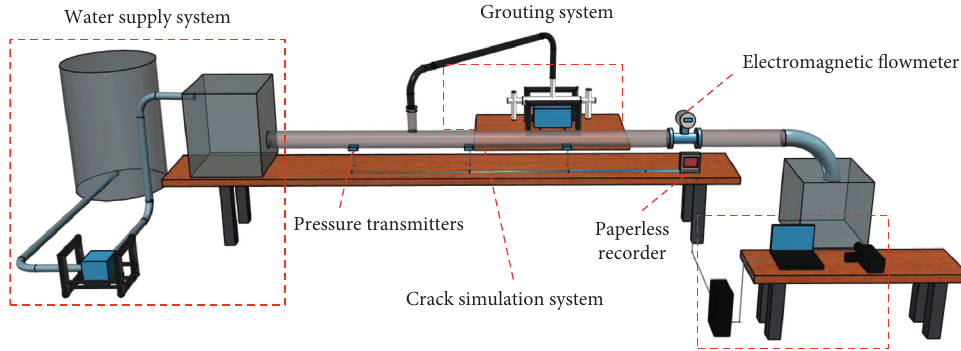
Figure 3: Self-developed test system of grouting plugs.